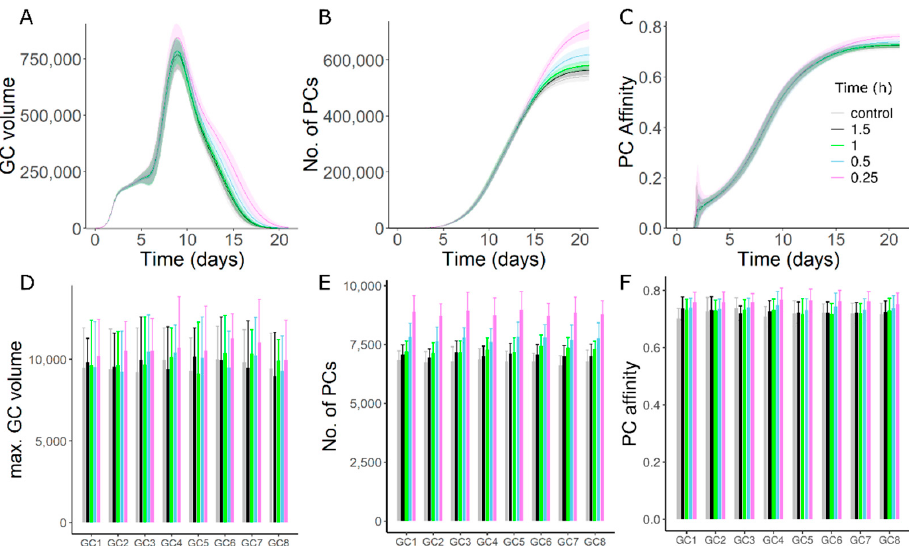
Figure 6. Persistent deposition of antigen in GC-FDCs. ( A ) Total volume of all GCs. ( B ) Total plasma cell production of all GCs. ( C ) Affinity of plasma cells from all GCs. ( D – F ) Maximum GC volume, number of plasma cells and affinity of plasma cells from individual GCs. Inset shows the time interval between consecutive antigen addition events to the FDCs during the GC reaction. No additional antigen was added after GC initiation in control simulations. GCs were synchronously initialized with a single epitope (shape space position 3333) and founder cell positions chosen randomly anywhere in the shape space. Low GC–GC interaction strength was considered in these